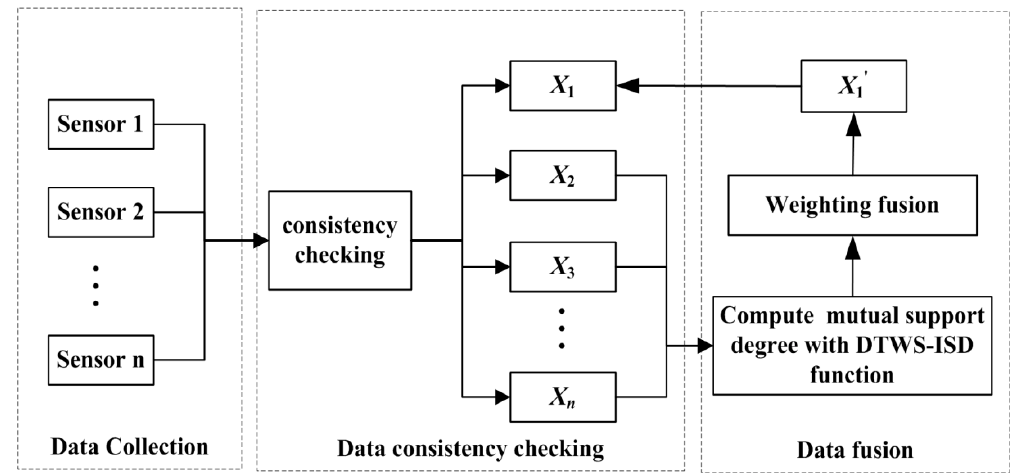
Figure 1. The flow chart of data correction.